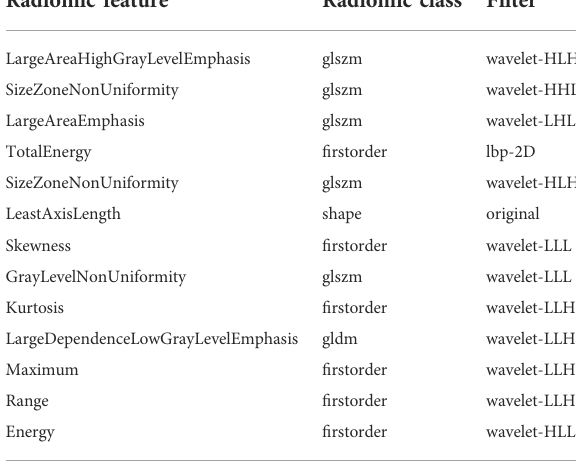
TABLE 2 Description of the selected radiomics features with their associated feature group and fi lter.